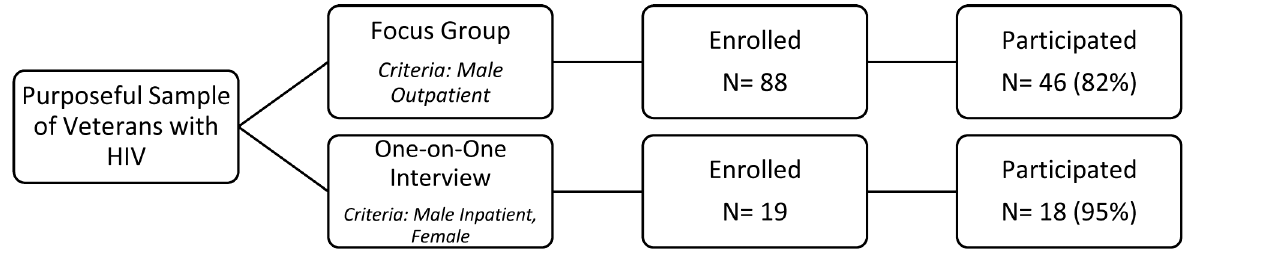
Fig 1. Participation flow